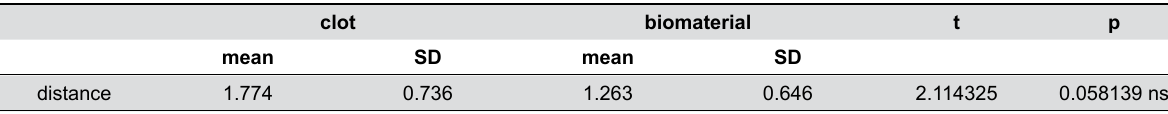
ns= no statistically significant difference Table 2- Measurement (HU) of bone density of the third molar socket clot